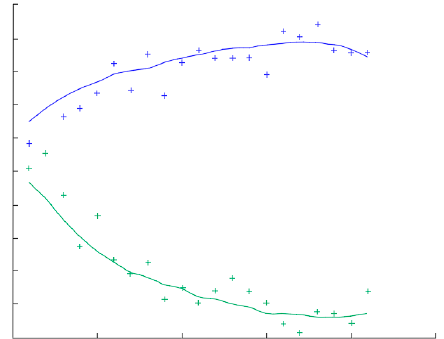
Figure 4. Example of a smoothing technique obtained by applying a low-pass